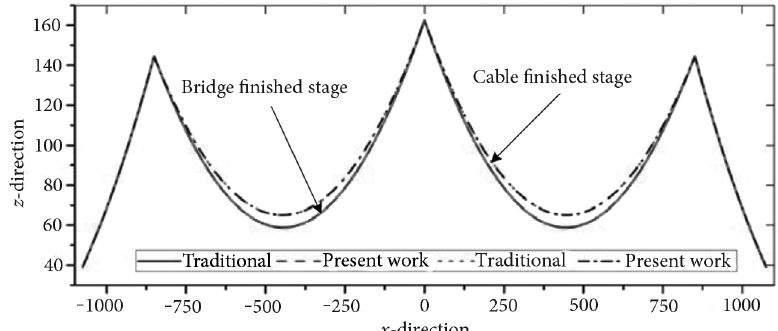
Fig. 7. Comparison of the calculated cable-shape under two different construction stages Table 4. Comparison of key parameters between finished bridge state and cable finished stage Load